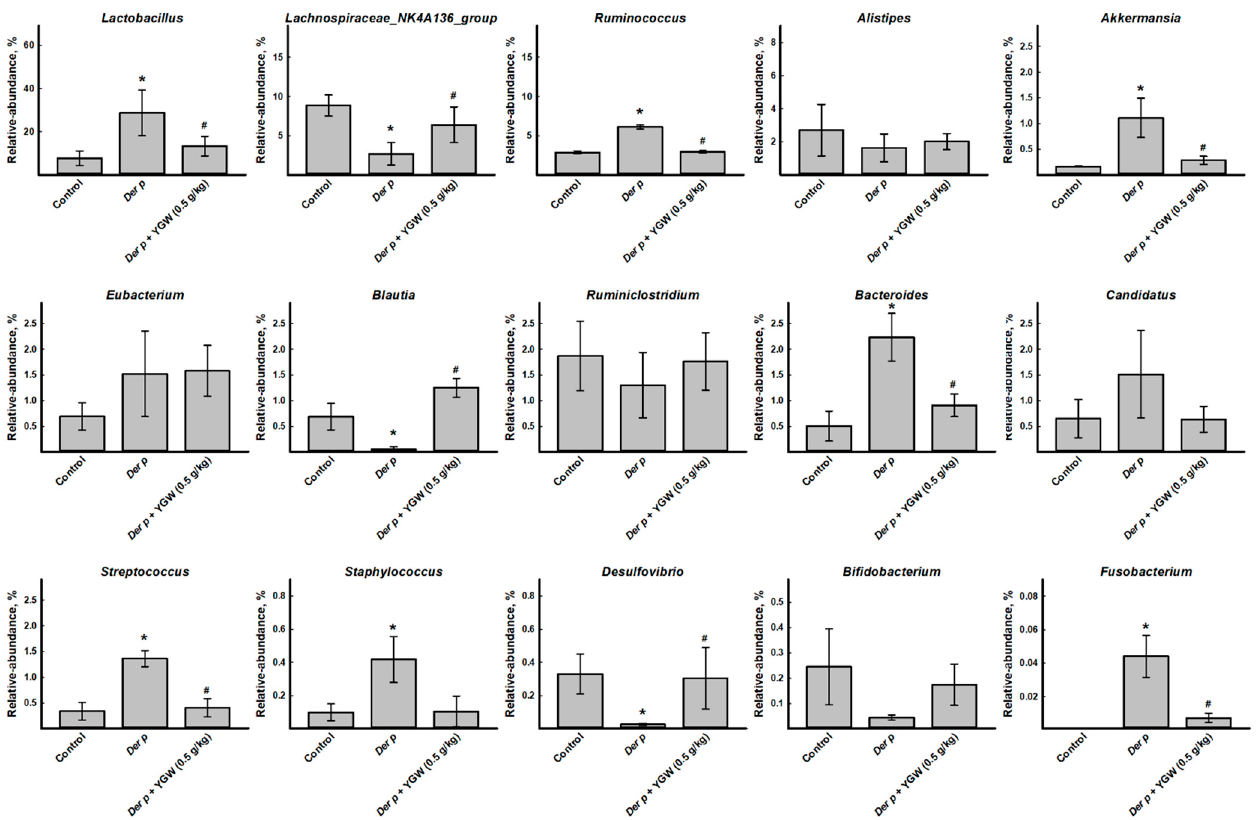
Figure 5. Relative abundance of the top 15 gut microbiota genera in control, Der p and Der p + YGW (0.5 g/kg) groups. Differential expression of genera of gut microbiota. Shows relative abundance of Lactobacillus , Lachnospiraceae , Ruminococ- caceae , Alistipes , Akkermansia , Eubacterium , Blautia , Ruminiclostridium , Bacteroides , Candidatus , Streptococcus , Staphylococcus , Desulfovibrio , Bifidobacterium , and Fusobacterium . Data are mean ± SEM. * p < 0.05 (vs control); # p < 0.05 (vs Der p